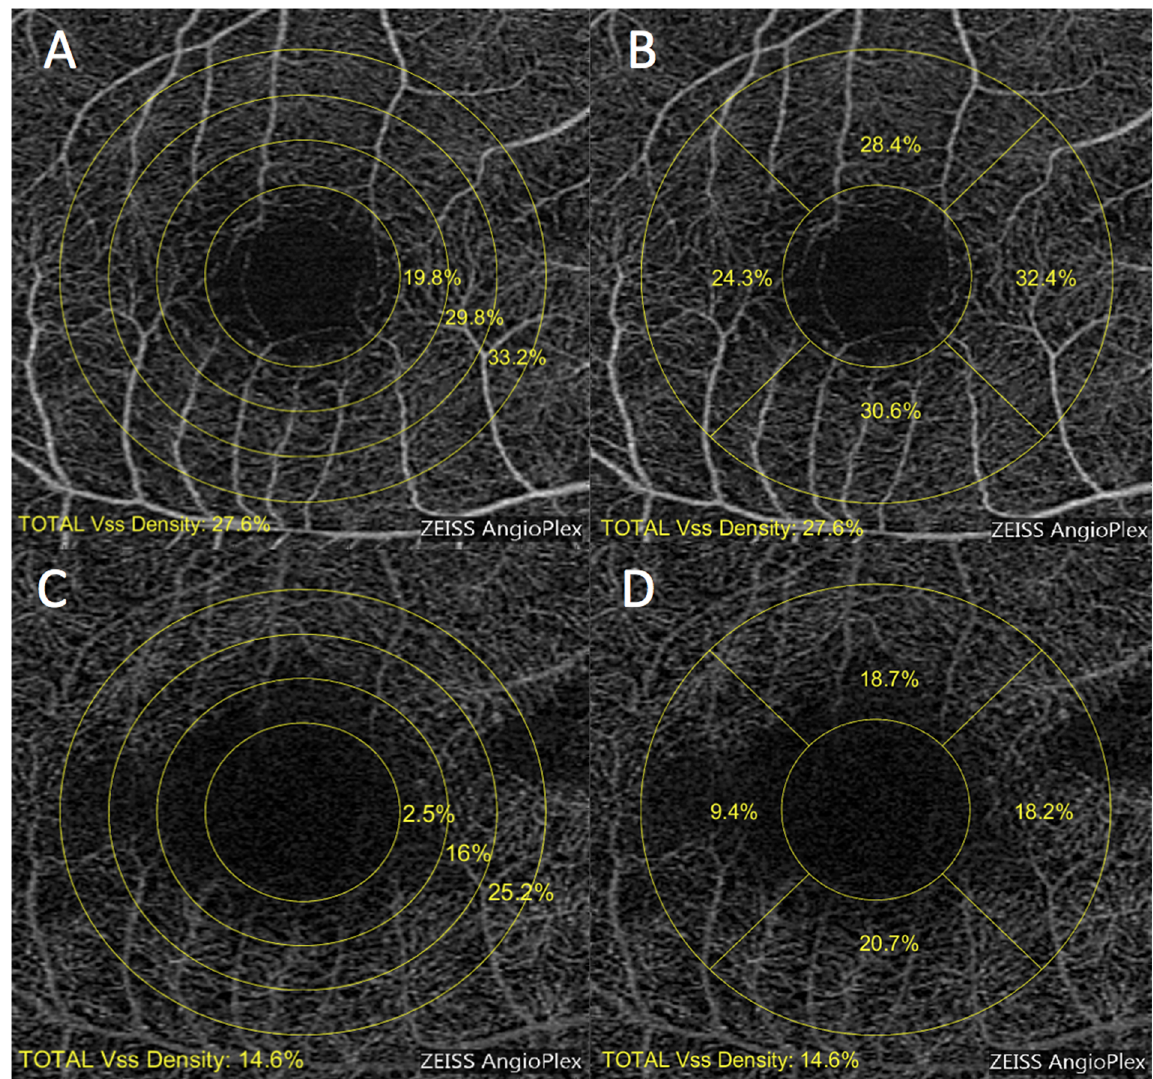
Fig 1. Macular vasculardensity at the different levels of 3 x 3-mm retinal vascularplexus. (A) Superficial retinal vascular plexus in circular segmentation. (B) Superficialretinal vascular plexus in quadrantsegmentation. (C) Deep retinal vascular plexus in circular segmentation. (D) Deep retinal vascular plexus in quadrantsegmentation. For the circular segmentation, vascular density was calculatedin three circular regions of different radius after excludingthe adjacent inner circle area. Each regioncorresponding to C1, C2, and C3 had a 1.5-mm, 2-mm, and 2.5-mm radiusfrom the center. The central area of 1-mm radiuswas excluded,most of which includedthe FAZ area. Similarly, quadrantsegmentation was performed in four sectors, namely, temporal(T), superior(S), nasal (N), and inferior (I) in the regionof 1-mm to 2.5-mm